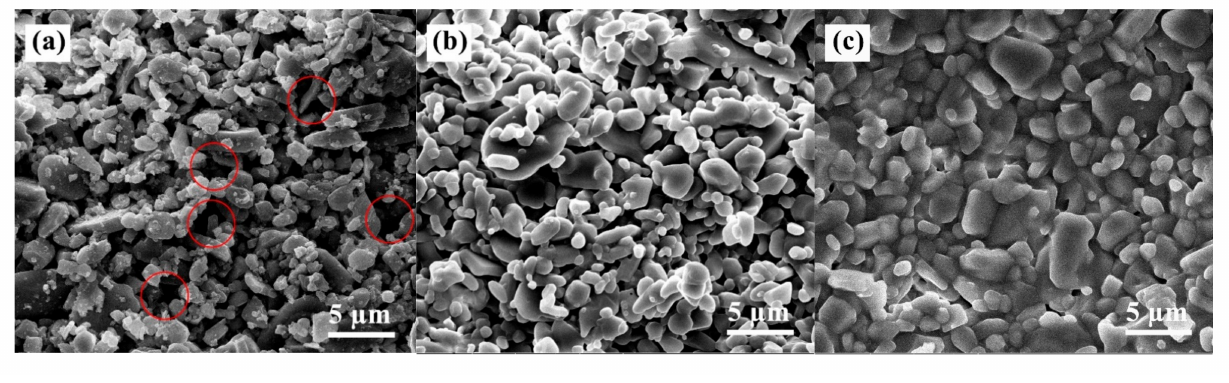
Figure 8. SEM images of the composite ceramics sintered at different temperatures. ( a ) green body; ( b ) 1400 ◦ C; ( c ) 1600 ◦